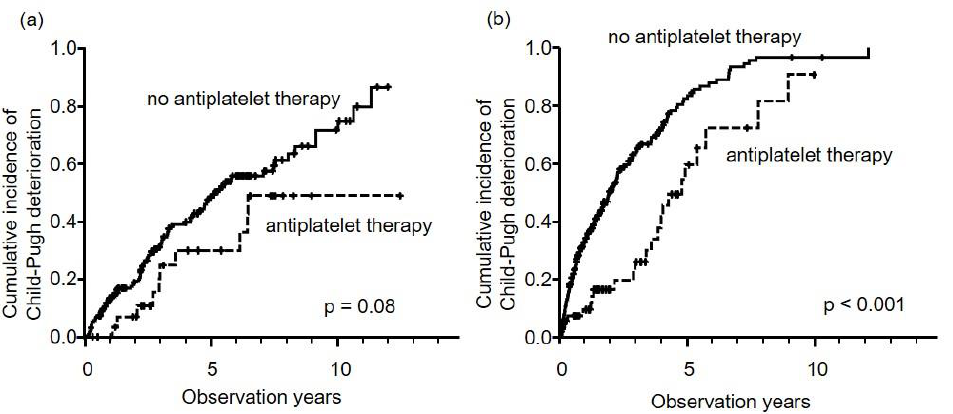
Figure 3. Cumulative incidence of Child–Pugh deterioration stratified by first treatment methods, i.e., curative therapy ( a ) and TACE ( b ). In curative therapy, five-year cumulative incidence rates of antiplatelet therapy (dotted line) and no antiplatelet therapy (solid line) were 30.0% and 48.6%, respectively ( p = 0.08). In TACE ( b ), five-year cumulative incidence rates of antiplatelet therapy (dotted line) and no antiplatelet therapy (solid line) were 59.6% and 82.4%, respectively ( p < 0.001).